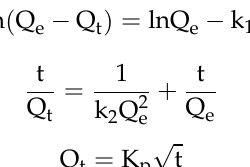
Table 1. Kinetic parameters for the adsorption of bisphenol A by ST-HEMA-GMA-BCD-NH 2 . Lagergren’s Pseudo-First-Order Ho’s Pseudo-Second-Order Model